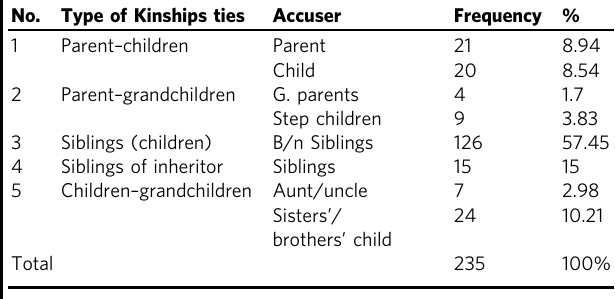
Table 1 distribution of disputes by kinship